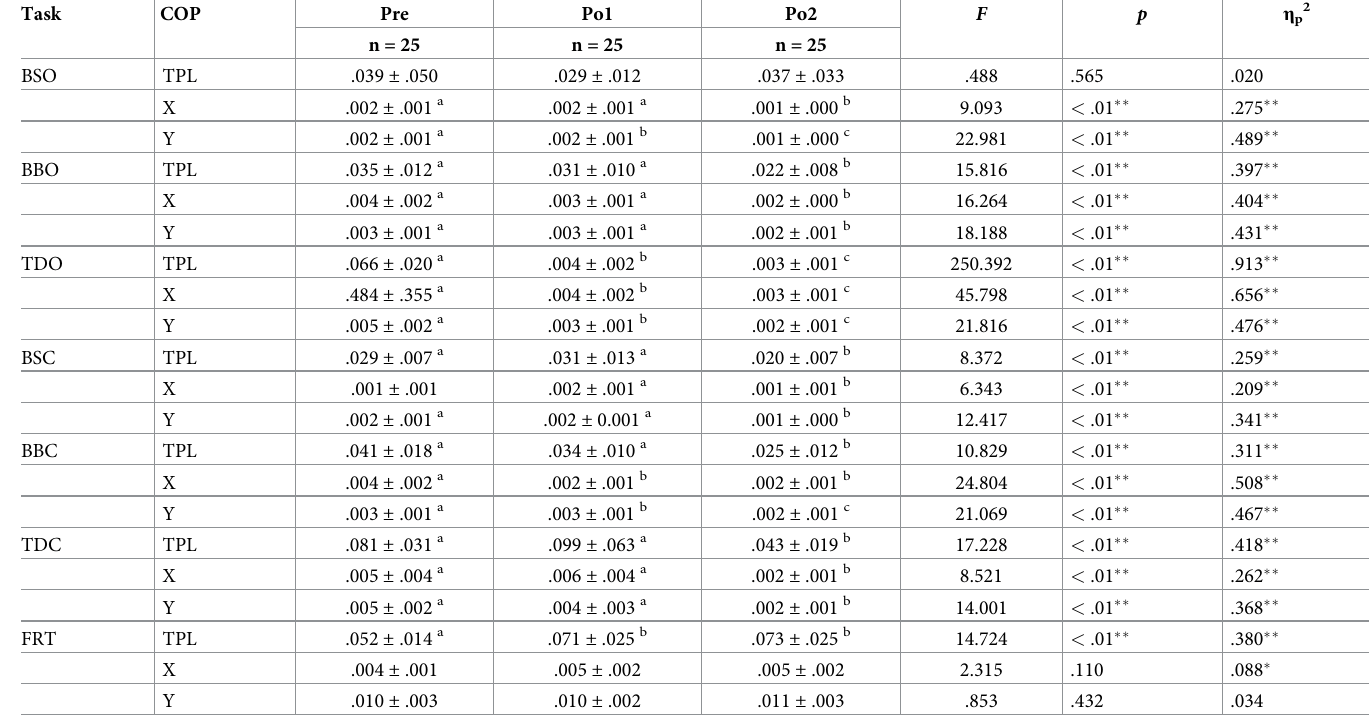
Table 3. Summary of repeated measure analysis of variance in center of pressure control during static stance and dynamic weight shifting.